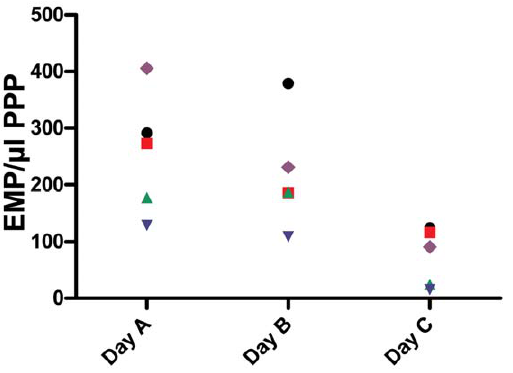
Figure 3. Evolution of EMP detected by flow cytometry in the in vivo study. 5 healthy volunteers were evaluated on 3 different study days (all 5 represented in a different color and symbol). Day A: blood was collected after an overnight fast. EMP were detected by flow cytometry as particles , 1 m m and CD31 + /CD42b 2 in PPP. Day B: NaCl 0.9% was administered in fasting conditions and the same measure- ments as on day A were performed. Day C: the same protocol was used as on day B, but a pure lipid solution was infused instead of NaCl. A lower number of EMP was detected in all healthy volunteers after intravenous administration of the lipid emulsion (p=0.012). EMP=en- dothelial microparticles, PPP=platelet poor plasma.